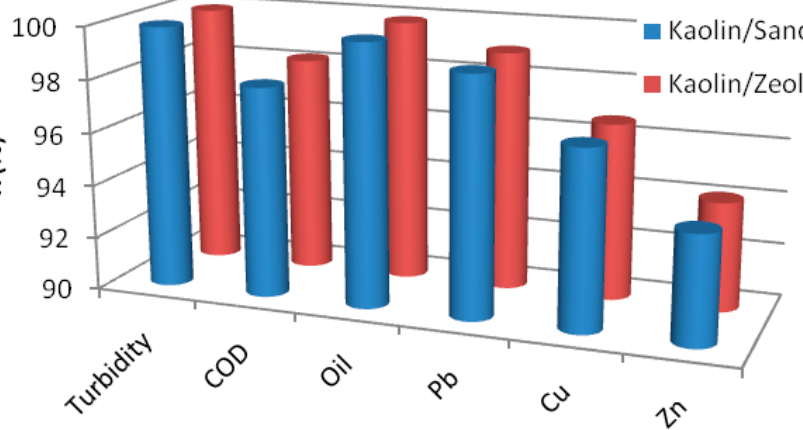
Figure 7. Retention of pollutants by different membranes at 1 bar for kaolin/sand and 3 bar for kaolin/zeolite.